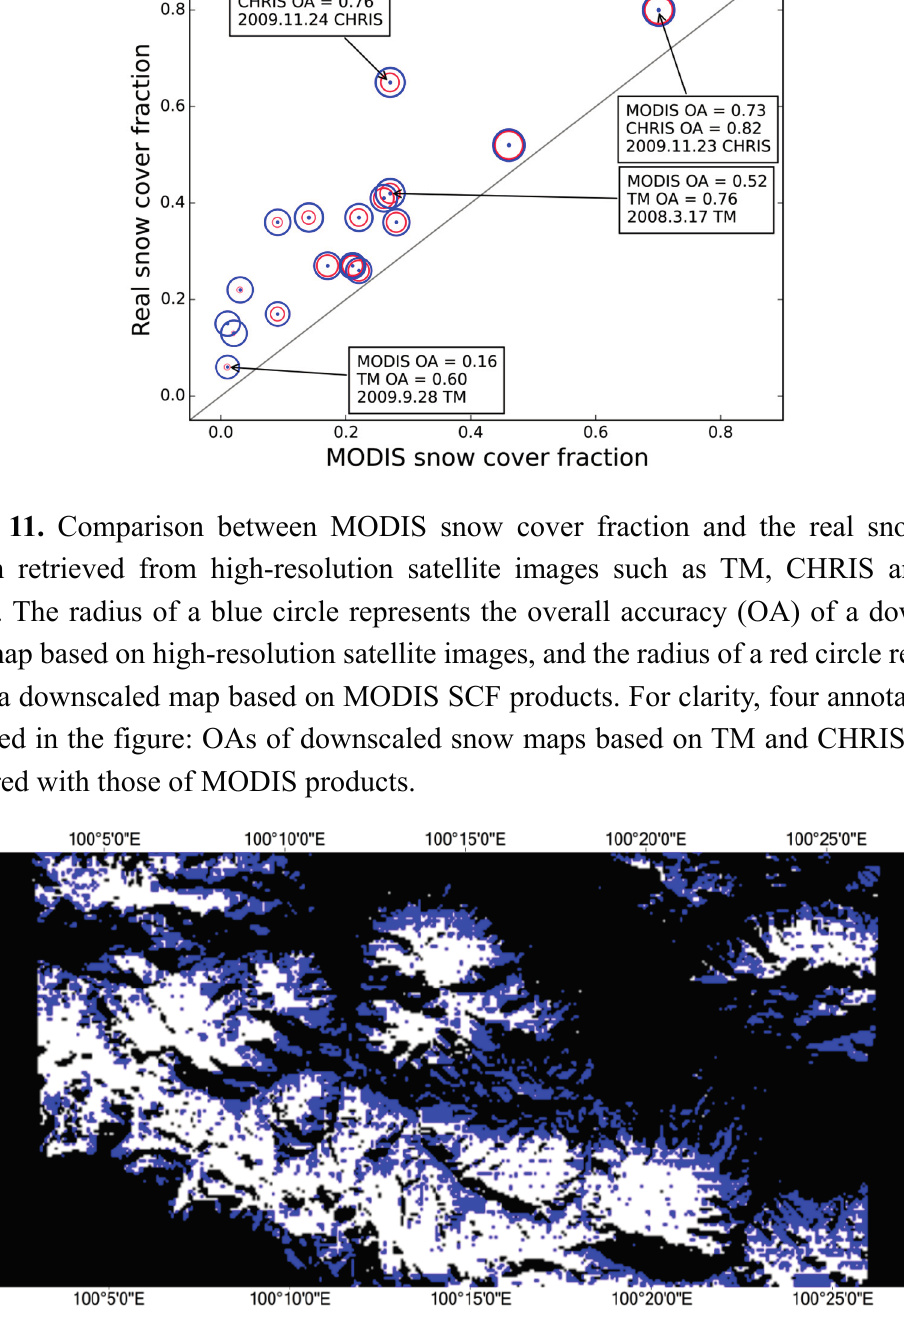
Figure 12. Differences between the MODIS-based downscaled and remotely sensed snow maps for 17 March 2008. Snow-free areas and areas lacking data are shown in black in both maps; snow-covered areas in the remotely sensed map that were identified as being snow-free in the downscaled map are blue; and snow-covered regions in both maps are white. This image can be compared with the downscaled snow map based on high-resolution images shown in Figure